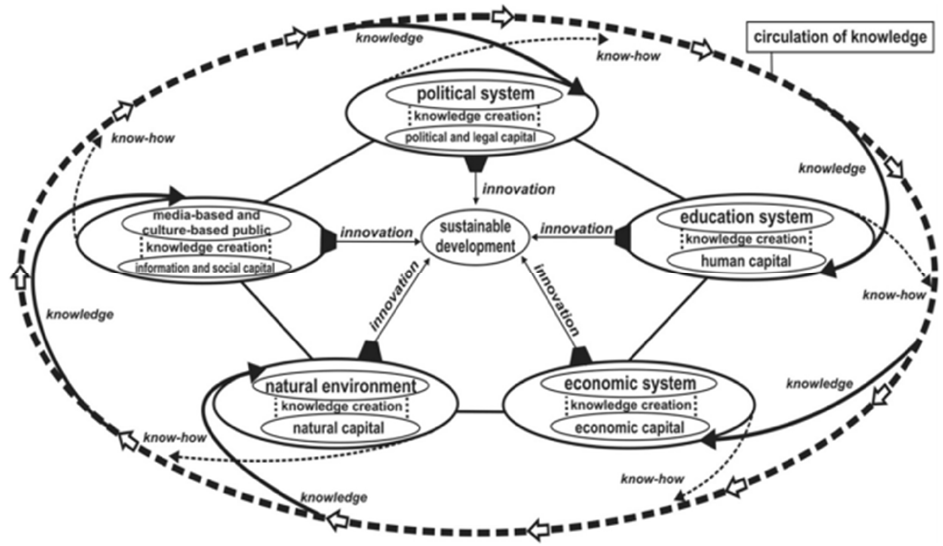
Figure 1. The Quintuple Helix Innovation Model (QHIM). Source: [10].